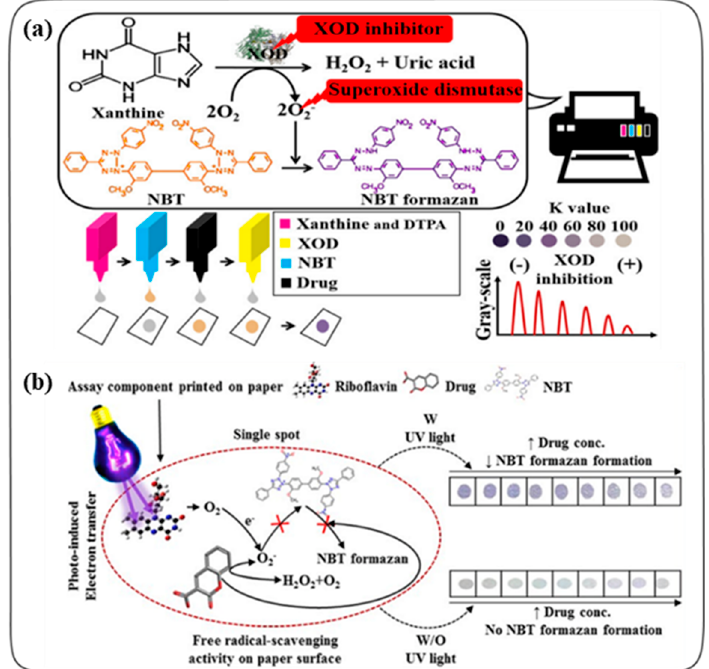
Figure 1. ( a ) Schematic representation of inkjet printing-based xanthine oxidase (XOD) inhibitory assay. Reprinted with permission from Ref. [31]. Copyright (2017) American Chemical Society. ( b ) Schematic illustration of inkjet printing-based radical scavenging assay on paper. Reprinted with permission from Ref. [32]. Copyright (2018) Elsevier.